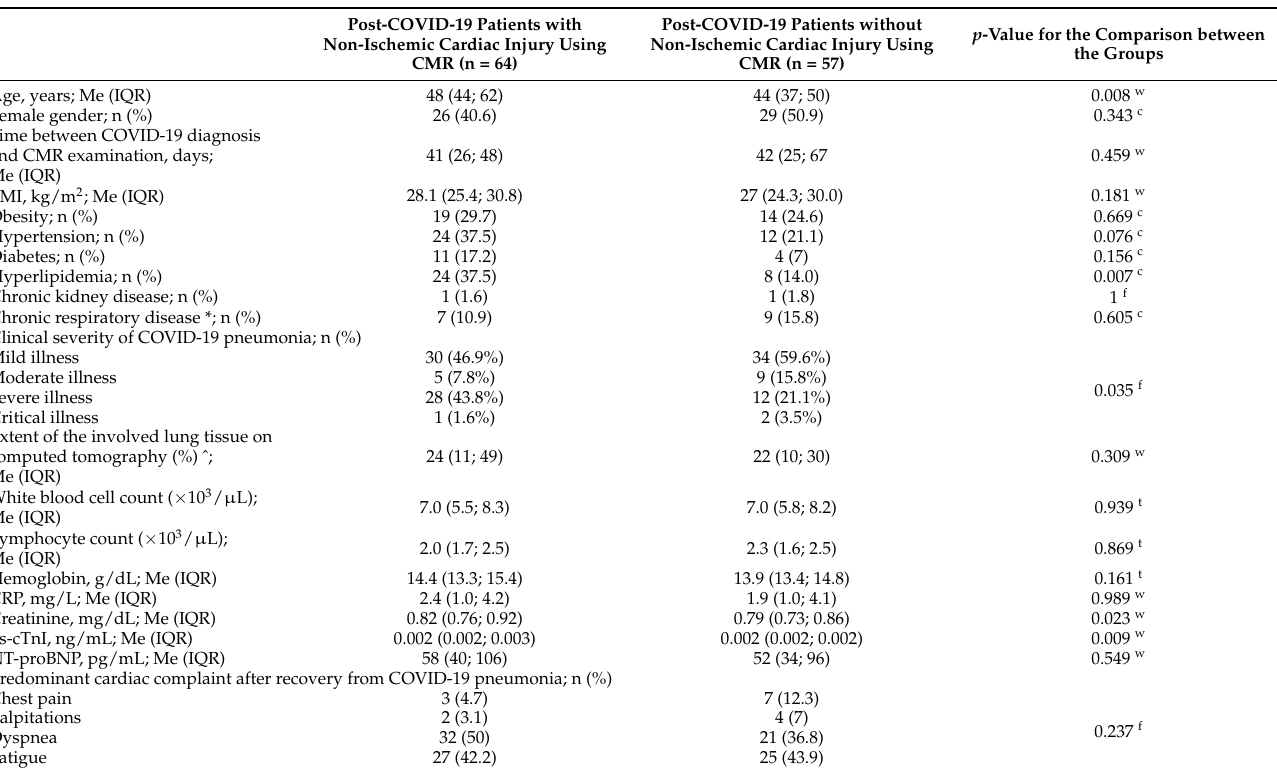
Table 3. Comparison of demographic, clinical, and laboratory characteristics between post-COVID-19 patients with and without non-ischemic cardiac injury. Non-ischemic cardiac injury indicates the presence of LGE and/or CMR features of active